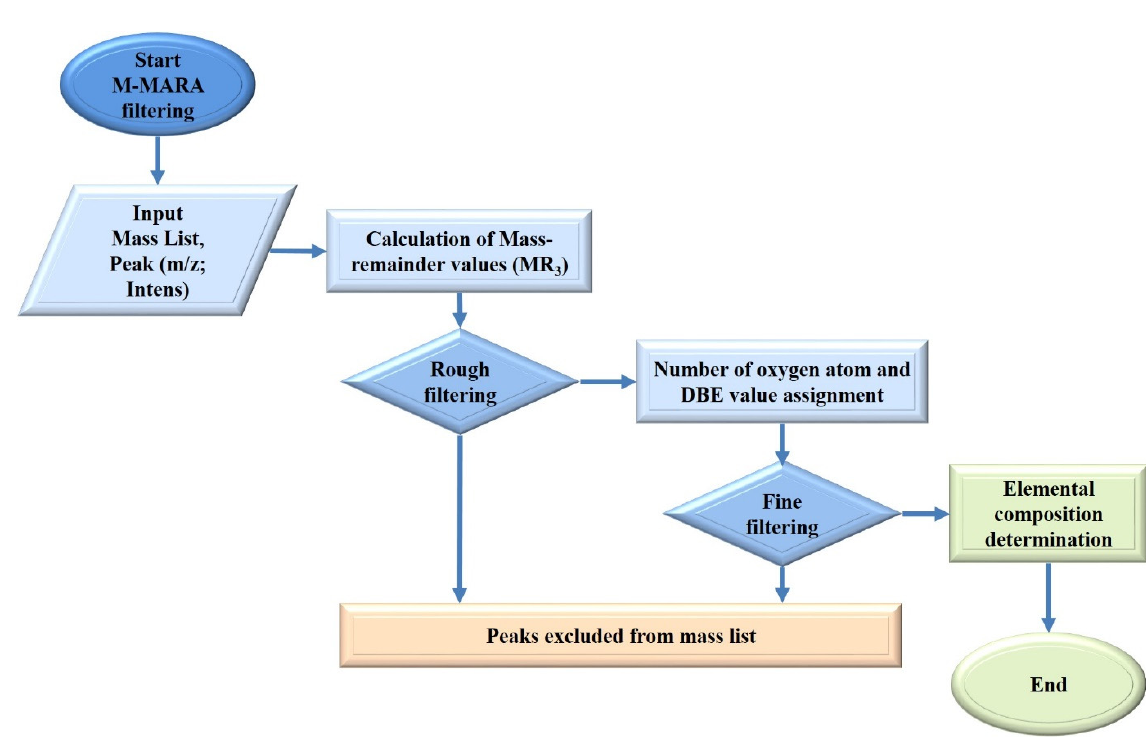
Scheme 2. Flowchart of the Multistep Mass Remainder Analysis (M-MARA) flavonoid filtering